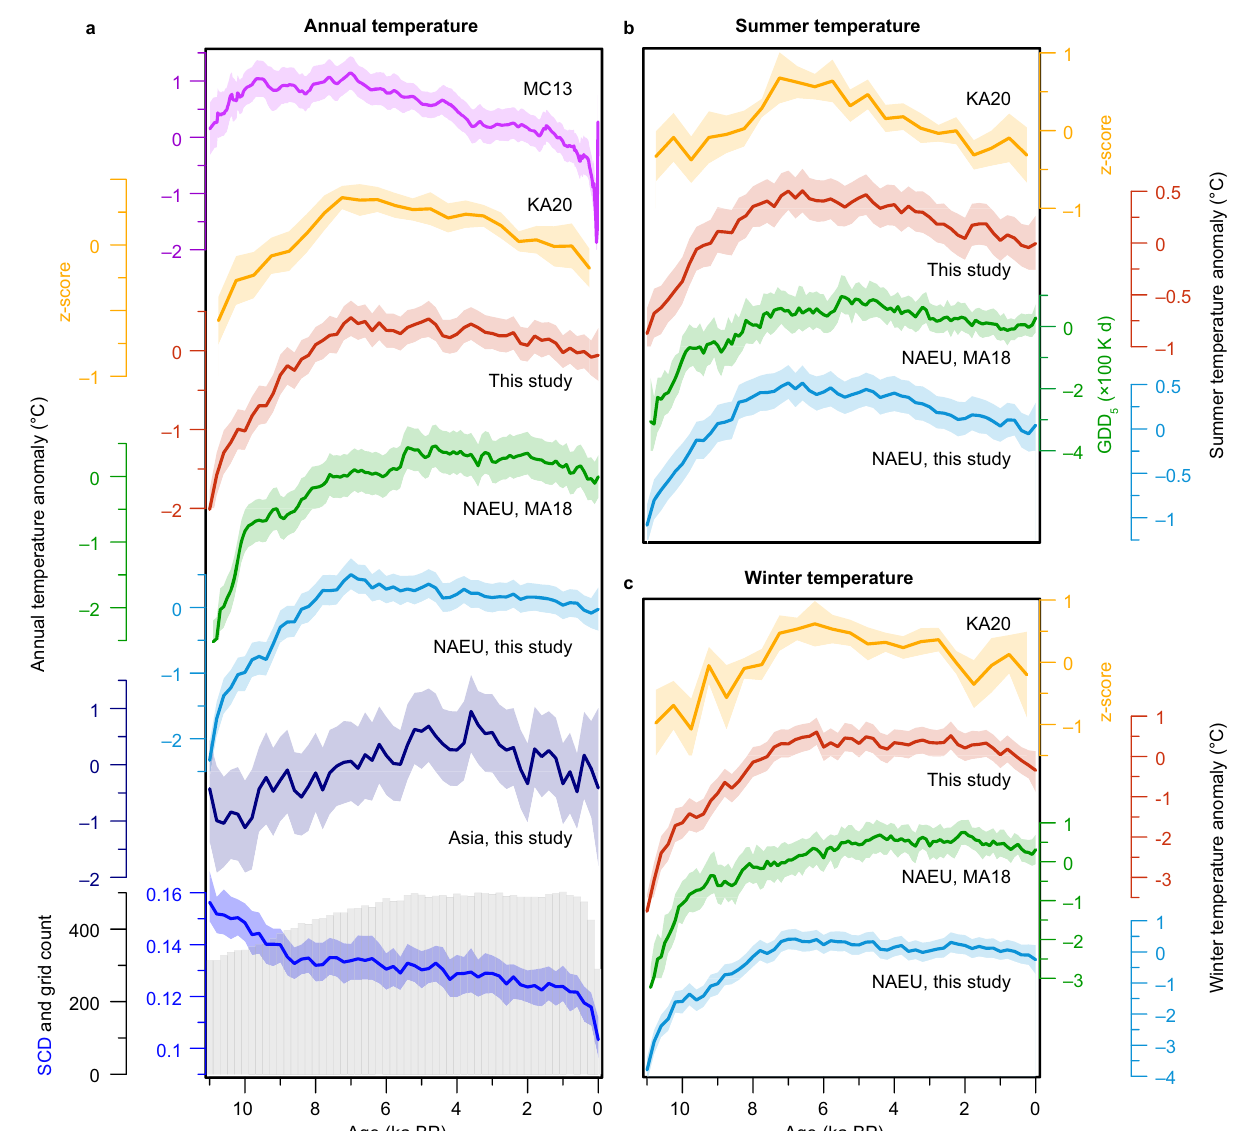
Fig. 1 | Multiproxy records of annual and seasonal temperature evolution during the Holocene. a Annual temperature trends from our pollen-based reconstructions over the Northern Hemisphere (NH) landmass (red), North Amer- ica and Europe (NAEU, teal), and Asia (dark blue) with the number of 2° × 2° grid cells for the temperature stack in 200-yr bins (grey bar) and mean squared chord distance (SCD; blue). This panel also shows a marine-dominated multiproxy stack for 30 – 90°N 2 (MC13), NH marine and terrestrial multiproxy stack 3 (KA20), and